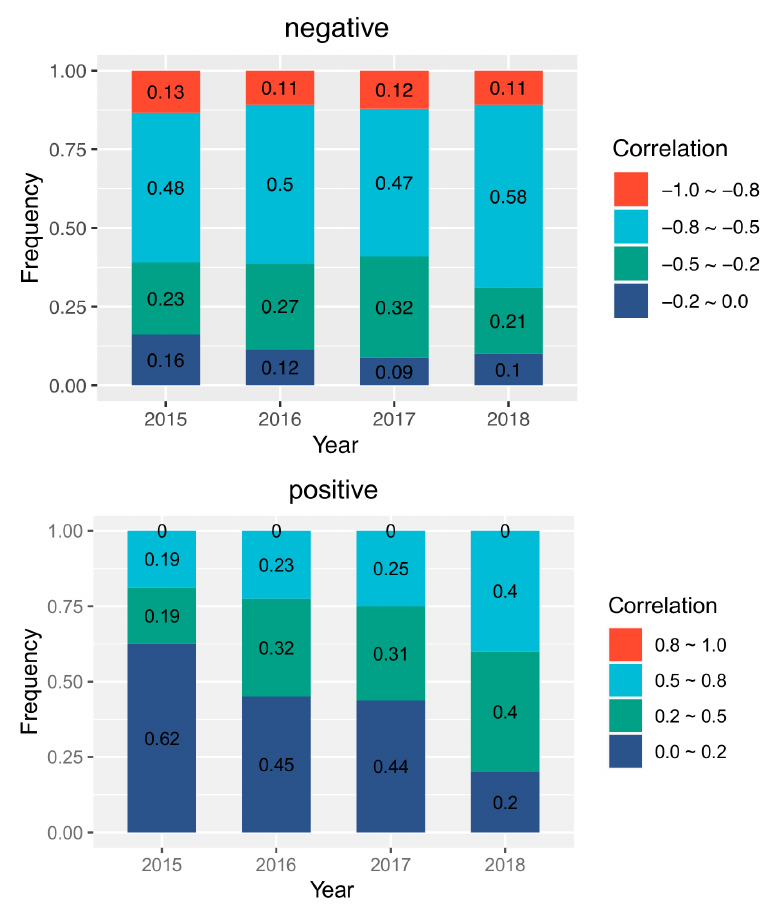
Figure 2. The annual variations of the frequency of negative CBO and positive CBO. Except for March, November and December, there are a considerable number of days in each month (Figure 3) when the mass concentrations of BC and O 3 are showed to be significantly positive CBO (0.5 < CBO < 0.8). Among these, June had the largest number, with a total of five days, accounting for 55.6% of the total days with positive CBO in this month. Furthermore, in October and August, days of significantly positive CBO accounted for about 50.0% and 40.0%, respectively. Thus, although negative CBO was more common than positive correlations overall, there are considerable periods with significantly high positive